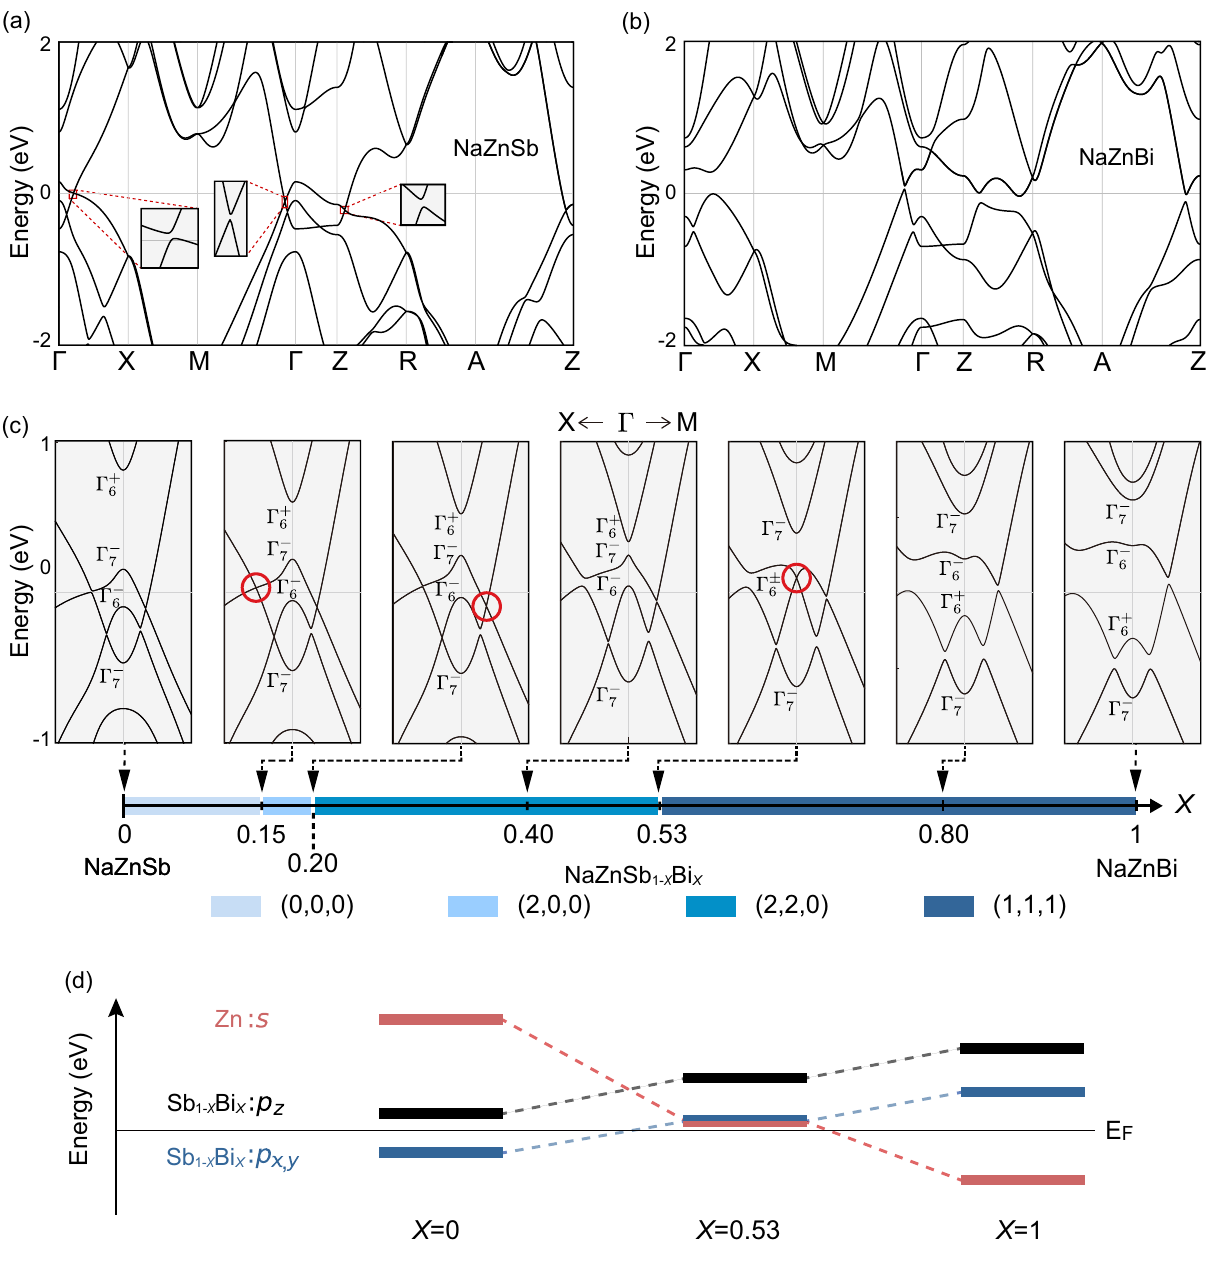
Figure 2. ( a ) First-principles bands of NaZnSb ( x = 0) with spin-orbit coupling. The red rectangles are magnified in the guided grey boxes, showing a direct bandgap. ( b ) DFT bands of NaZnBi ( x = 1). ( c ) DFT bands of NaZnSb 1 x Bi x for various x and topological phase diagram in x -space. The bands are drawn near the Ŵ point − along with the X and M directions, with the corresponding chemical composition x being indicated in the topological phase diagram. The red circles in the bands highlight the massless (zero-gap) Dirac points, which appear at the topological phase boundaries. Domains in different colors indicate distinct topological phases. ( d ) Schematic diagram of the orbital characters at Ŵ as a function of x . The Zn- s and Sb 1 inverted at x = 0.53, responsible for the change of the strong Z 2